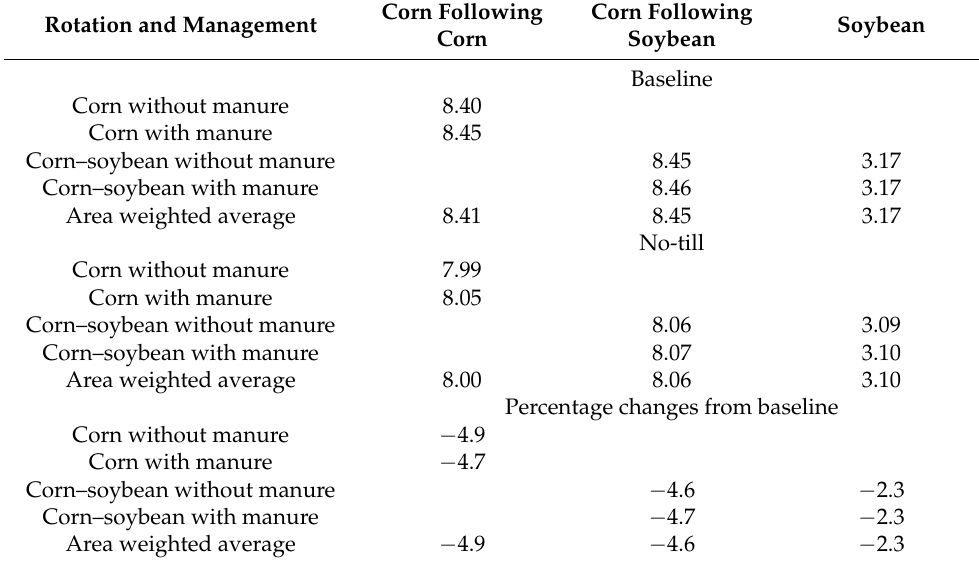
Table 8. Conservation tillage impacts on corn and soybean yields